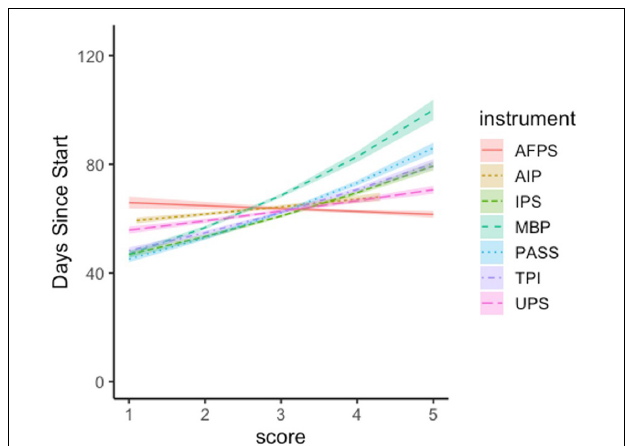
FIGURE 4 | Respondents’ scores on many of the self-report measures of procrastination predicted the amount of time that elapsed before they completed the research study. The strength of this relationship differs across instruments. Error bars represent ± 1 SE